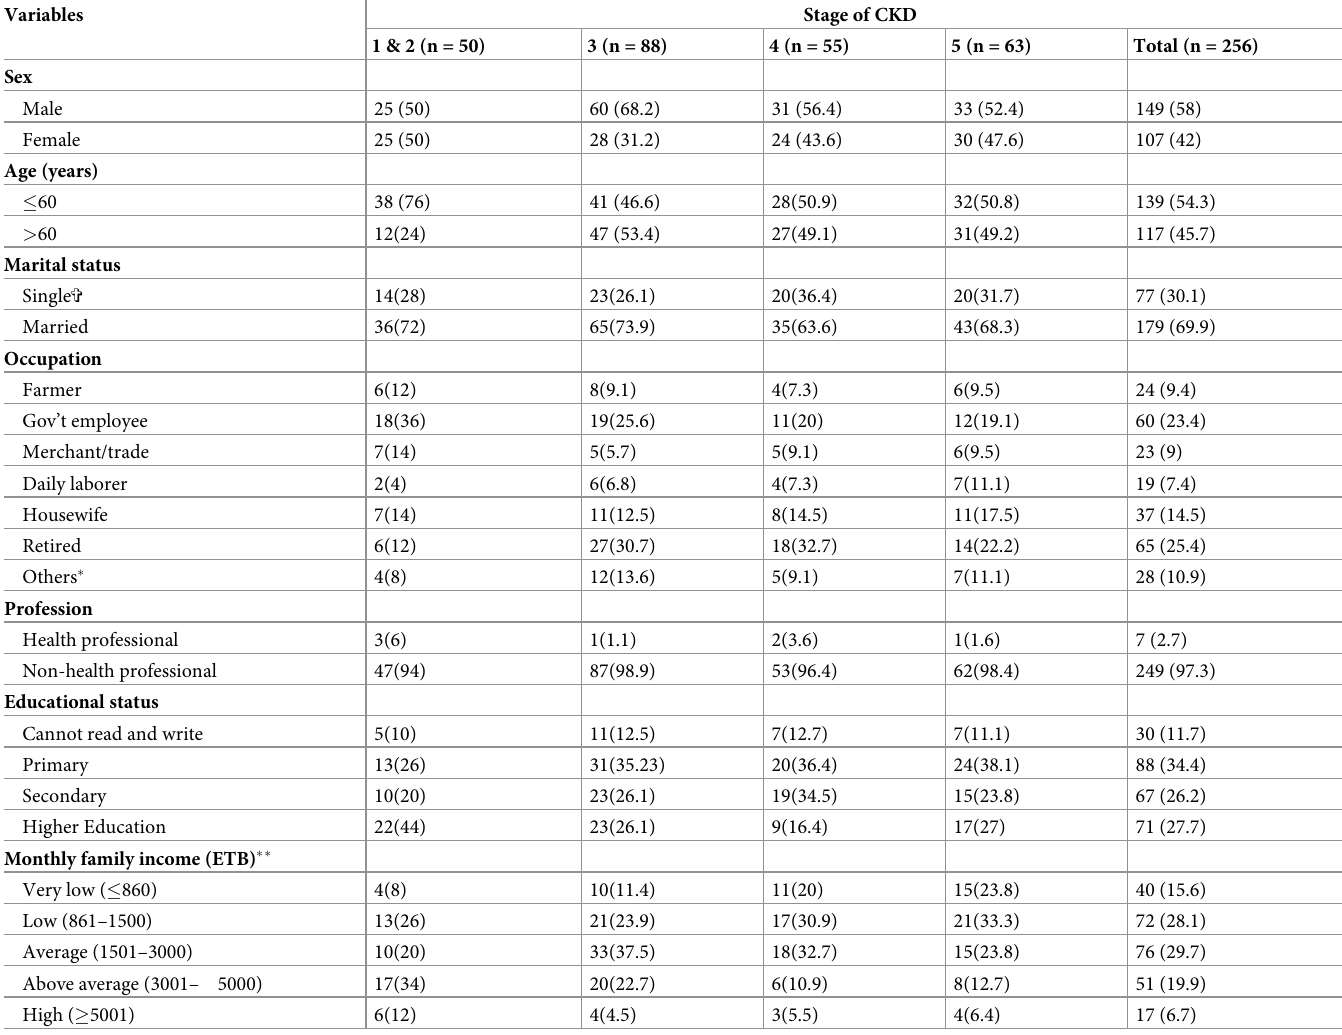
Table 1. Socio-demographic characteristic of chronic kidney disease patients attending the renal clinic of Tikur Anbessa Specialized Hospital. Variables Stage of